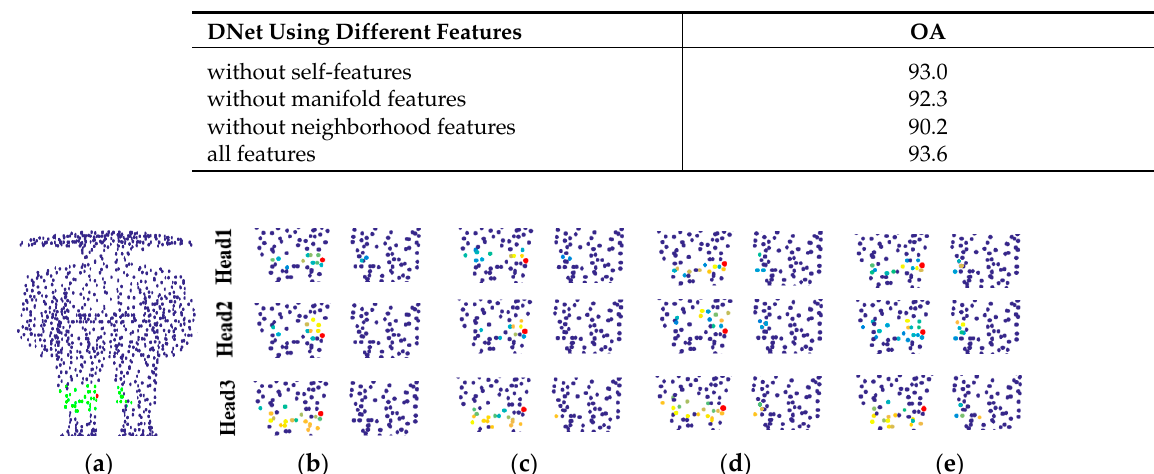
Table 7. Classification accuracy of DNet using different features on ModelNet40 dataset.